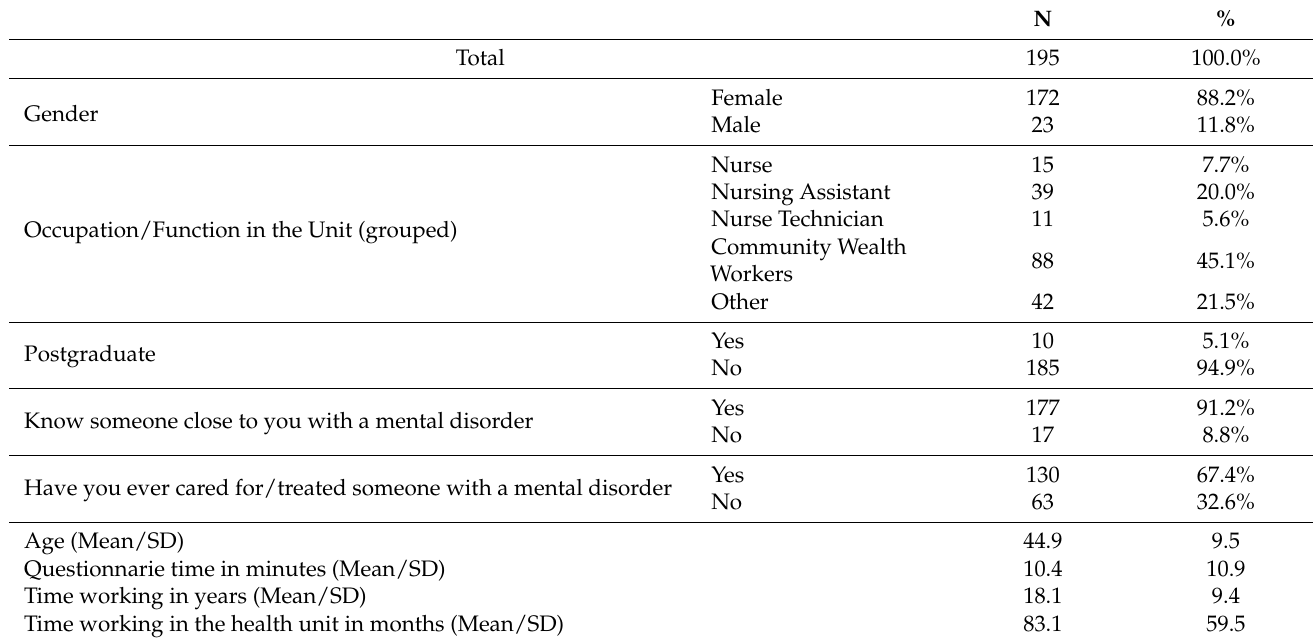
Table 1. Characteristics of the